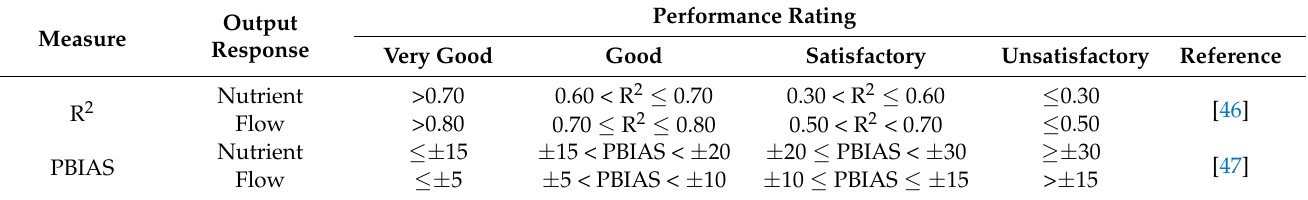
Table 2. General performance ratings of the recommended statistics for a monthly time